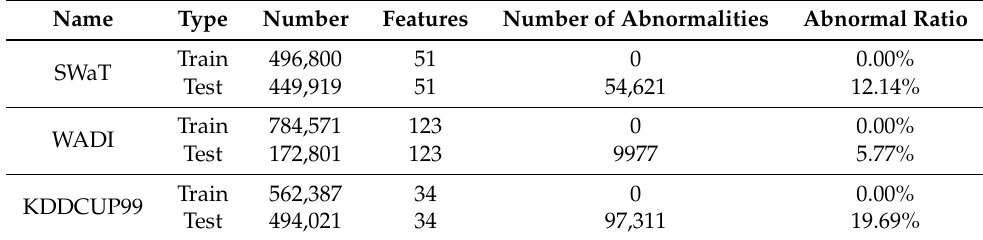
Table 1. Statistics of the three datasets used in